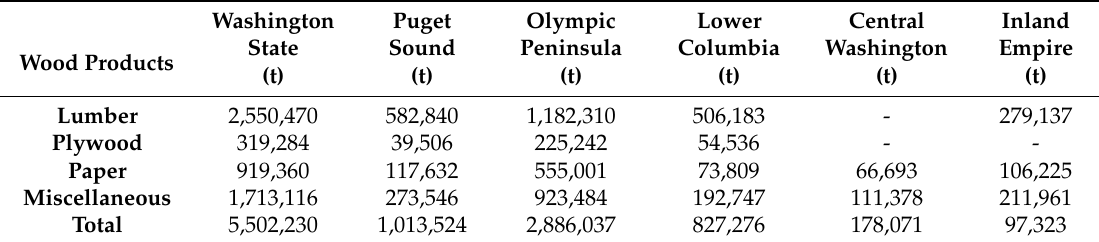
Table 3. Wood products mix for the overall Washington state and by economic area from merchantable harvested biomass from private forests in 2015. All values are reported in bone-dry